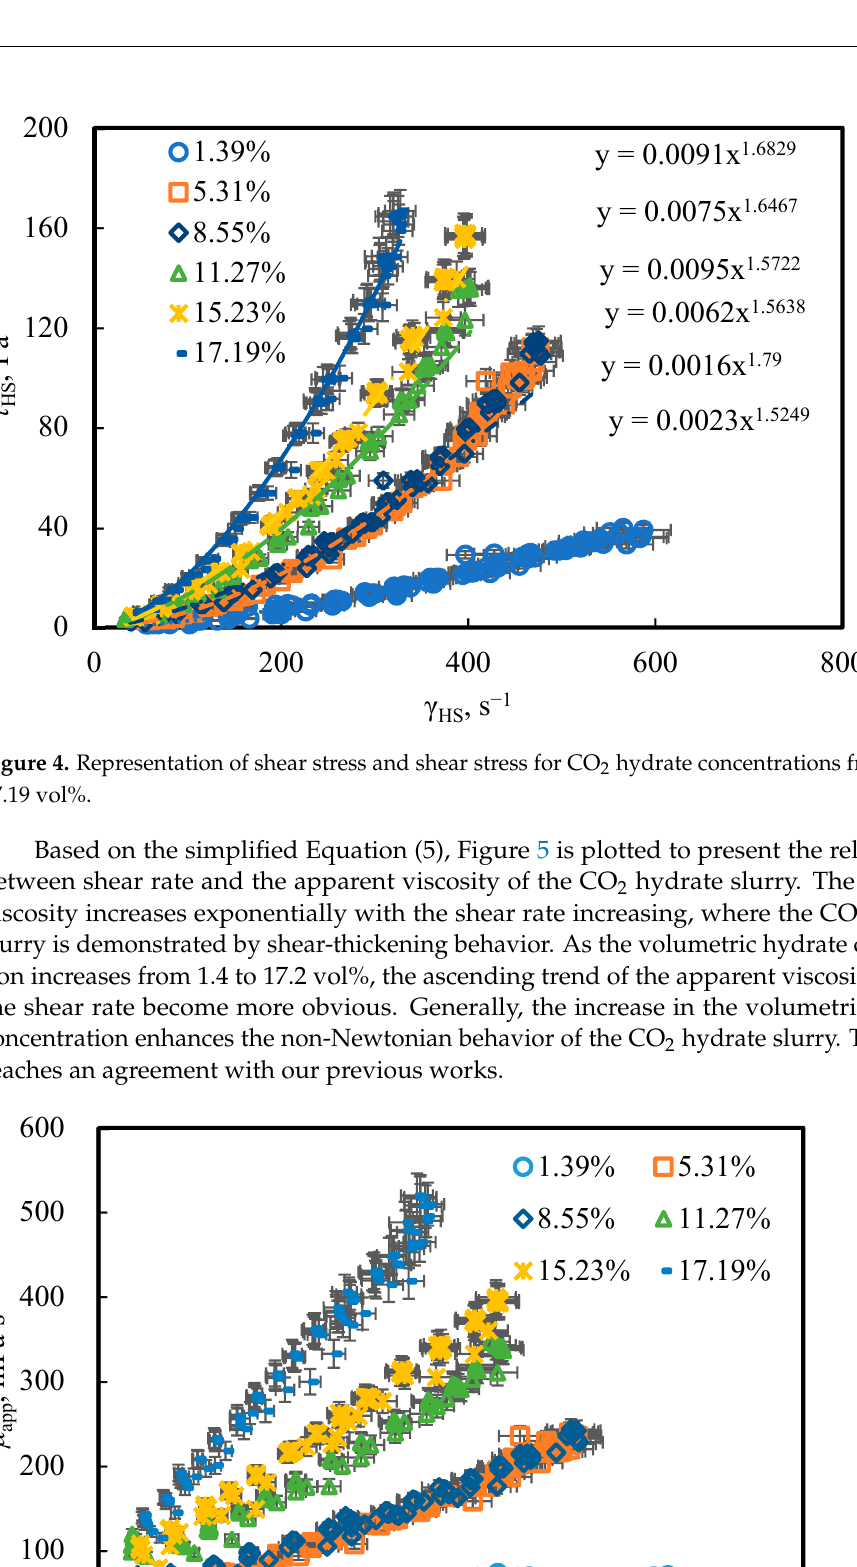
Figure 5. Representation of shear rate and apparent viscosity for CO 2 hydrate concentrations from 1.39 to 17.19 vol%.